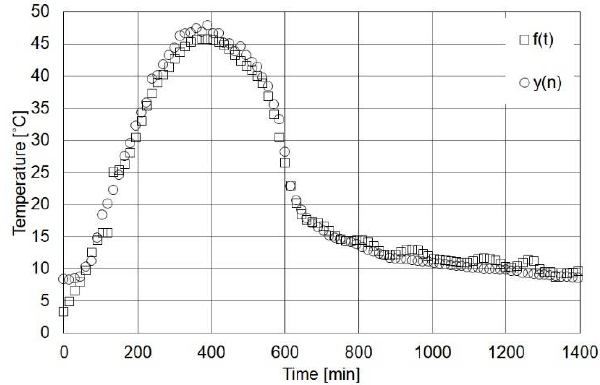
Figure 7. Measured temperature data points versus the continuous function provided by the signal reconstruction algorithm for an exposed wall in sunny spring conditions (ESS).